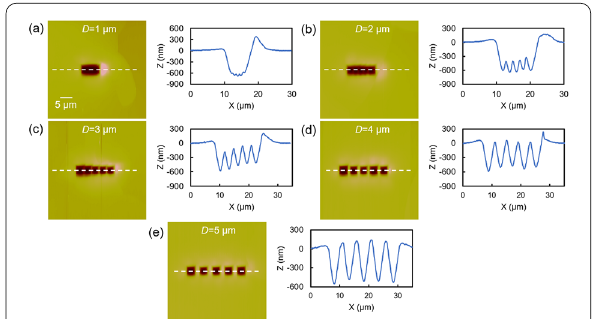
Figure 11 AFM images and the corresponding cross-sections of the experimental results for the one array indentations with the rotation angle of 45° and the spacings of a 1 μm, b 2 μm, c 3 μm, d 4 μm and e 5